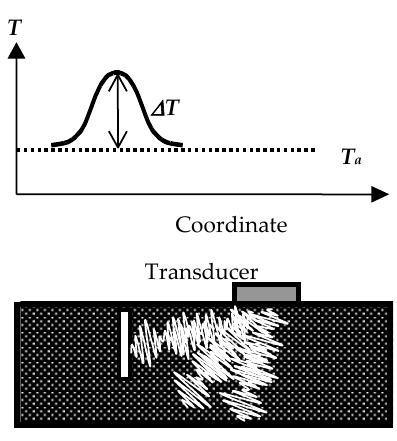
Figure 3. Vibrothermography principle [21].